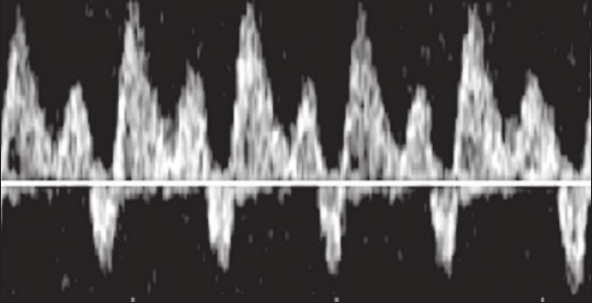
Figure-3: Pulsed-wave Doppler image of a triphasic waveform of a ductus venosus.